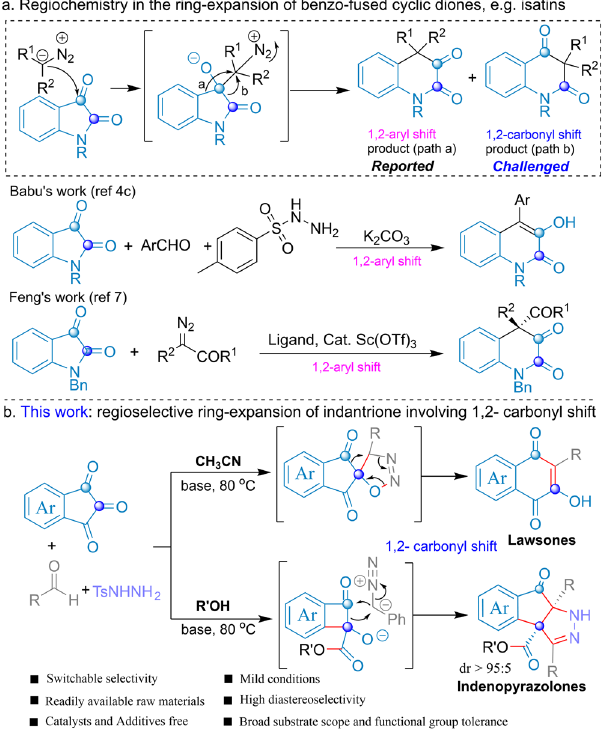
Fig. 2 Representative bioactive compounds. Such as Lawsone derivatives with tubulin, CDK, and HIF-1 inhibitions and indenopyrazole derivatives with antimalarial and antipneumocystic